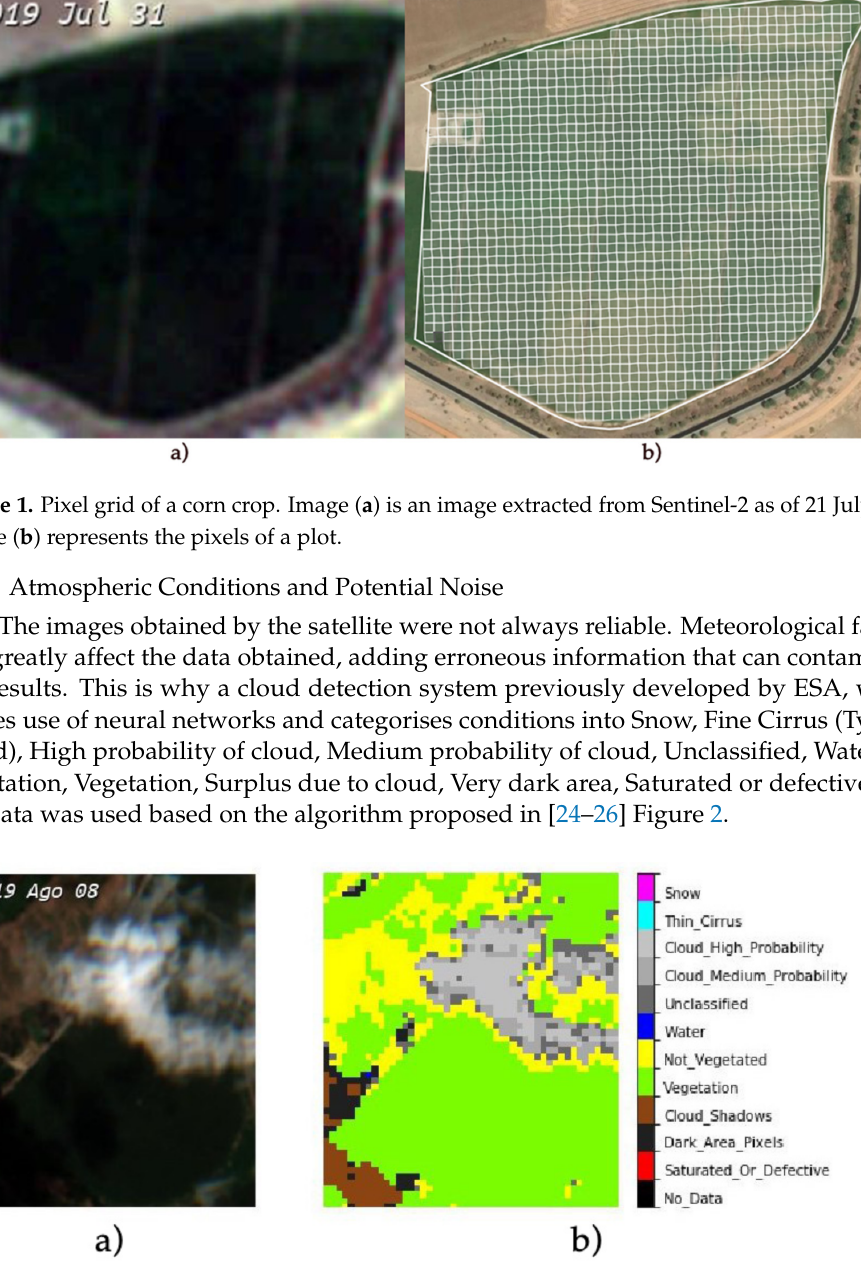
Figure 2. ( a ) Sentinel 2 RGB image sample with a ( b ) mask after the output of the atmospheric variable detection model provided by the European Space Agency